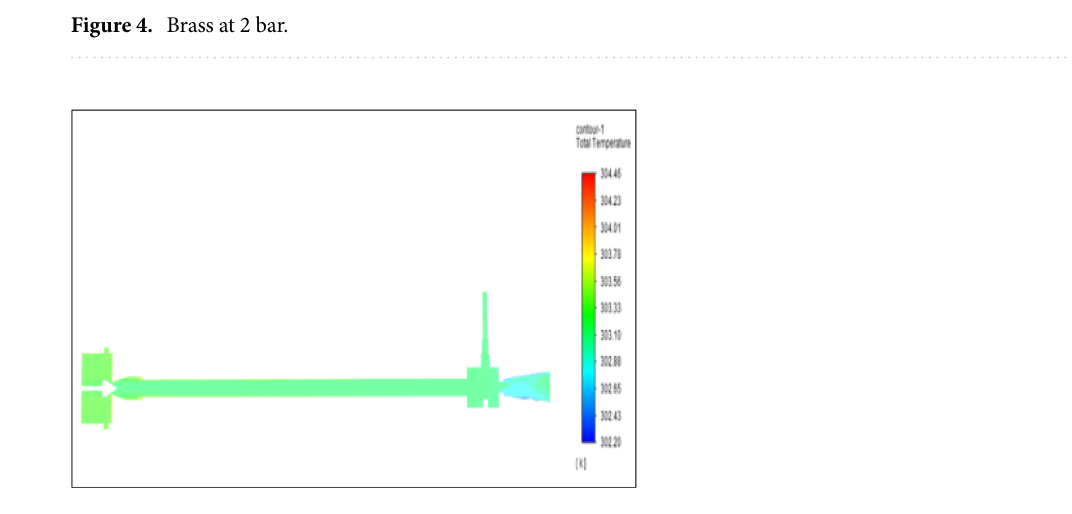
Figure 5. PVC at 2